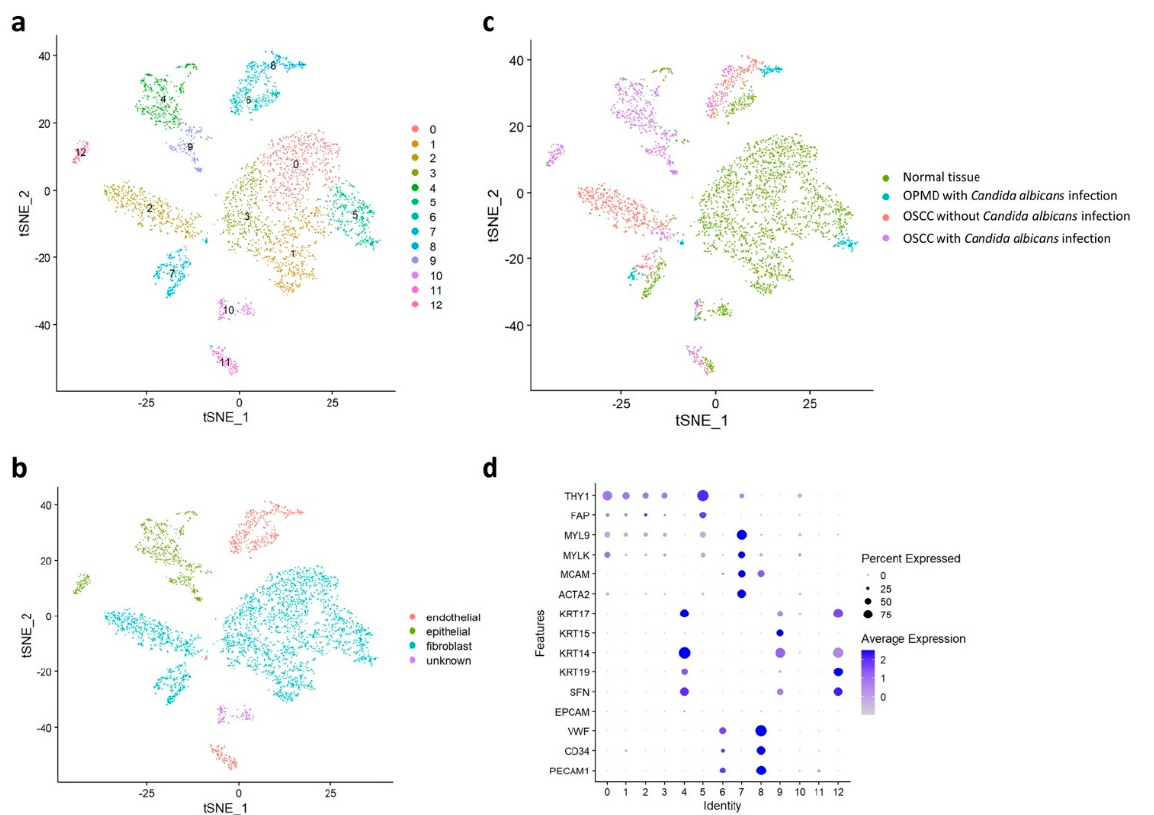
Figure 2. Cancer-related cell distribution in the normal tissue, OPMD lesion with Candida albicans infection, OSCC tissue with C. albicans infection, and OSCC tissue without C. albicans infection. ( a ) Classification of cancer − related cells into 13 subtypes by using the Louvain algorithm. ( b ) Classifi- cation of cancer-related cells into endothelial, epithelial, fibroblast, and unknown cells. ( c ) Separation of the four major groups. ( d ) Classification of cell types in each cluster by using specific bi- omarkers.